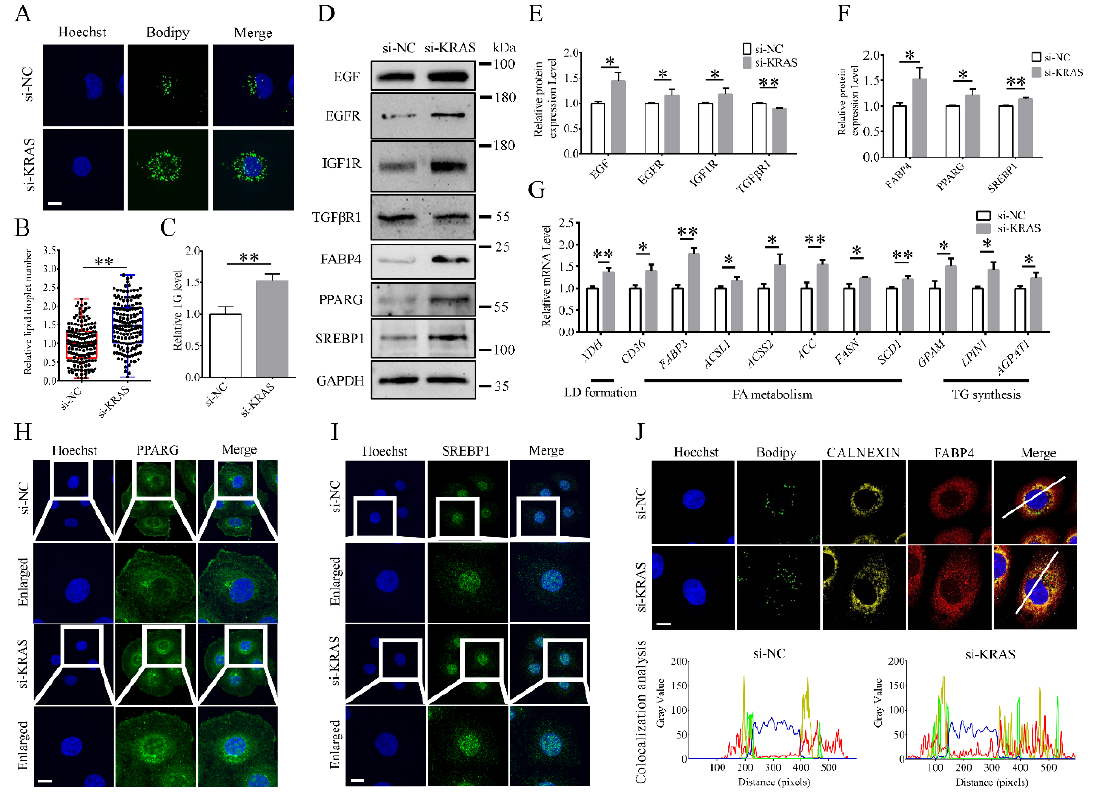
Figure 3. Effects of Kirsten rat sarcoma viral oncogene homolog (KRAS) on the synthesis of milk fat in MAC-T cells. ( A , B ) Representative Bodipy staining images and relative changes in milk fat content with or without KRAS inhibition. Bar = 10 μm. The experiments were performed five times. The red line indicates the si-NC group, the blue line indicates the si-KRAS group. ( C ) Relative triglyceride (TG) level changes in MAC-T cells with or without KRAS inhibition. ( D – F ) Representative Western blot images of peroxisome proliferator-activated receptor gamma (PPARG), sterol regulatory element-binding protein (SREBP1), fatty acid-binding protein (FABP) 4, epidermal growth factor (EGF), EGF receptor (EGFR), IGF1 receptor (IGF1R), and transforming growth factor beta receptor type 1 (TGFβR1) and the relative protein level assays in MAC-T cells with or without KRAS inhibition. ( G ) Relative mRNA expression levels of xanthine dehydrogenase ( XDH ), CD36 , FABP3 , acyl-CoA synthetase long-chain family member 1 ( ACSL1 ), acyl-CoA synthetase short-chain family member 2 ( ACSS2 ), acetyl-CoA carboxylase ( ACC ), fatty acid synthase ( FASN ), stearoyl-CoA desaturase 1 ( SCD1 ), glycerol-3-phosphate acyltransferase ( GPAM ), lipin 1 ( LPIN1 ), and 1-acylglycerol-3-phosphate O-acyltransferase 1 ( AGPAT1 ) with or without KRAS inhibition in MAC-T cells. ( H , I ) Representative immunofluorescence images of PPARG and SREBP1 in MAC-T cells with or without KRAS inhibition. Bar = 10 μm. ( J ) Representative immunofluorescence images of Bodipy, FABP4, and CALNEXIN colocalization analysis in MAC-T cells with or without KRAS inhibition. Bar = 10 μm. The fluorescence signals of Hoechst, Bodipy, CALNEXIN, and FABP4 were repre-